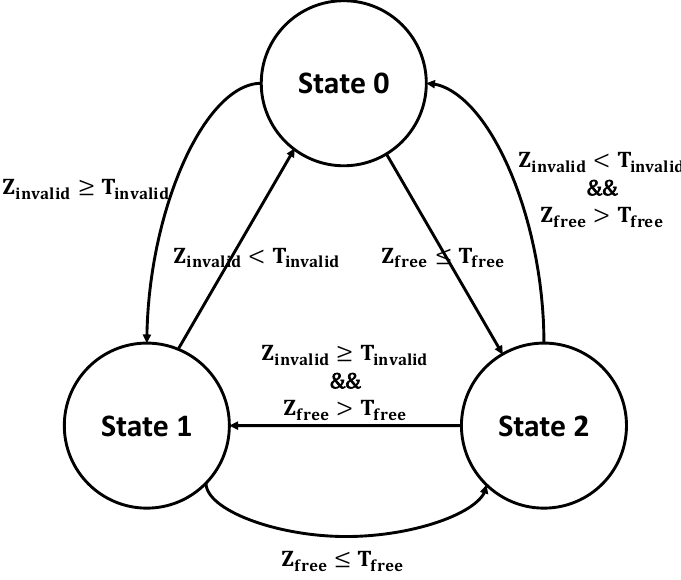
Figure 5. State diagram of Preemptive Zone